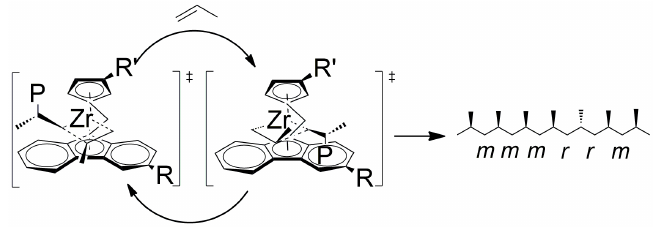
Figure 7. Enantiomorphic site control polymerization mechanism with catalyst 3 : chain migratory mechanism and backskips of the polymer chain to its original position (epimerization) after every insertion.